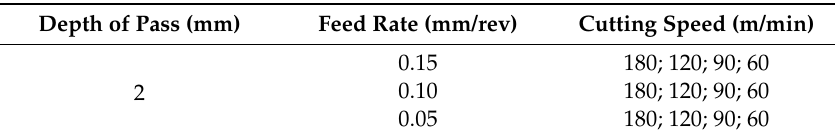
Table 5. Cutting parameters in turning